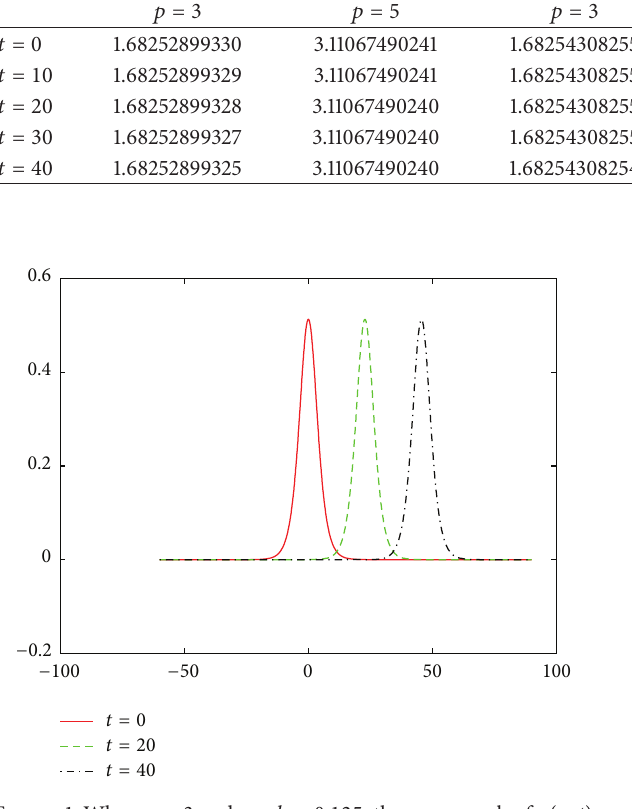
Figure 1: When 𝑝 = 3 and 𝜏 = ℎ = 0.125 , the wave graph of 𝑢(𝑥,𝑡) at various times.